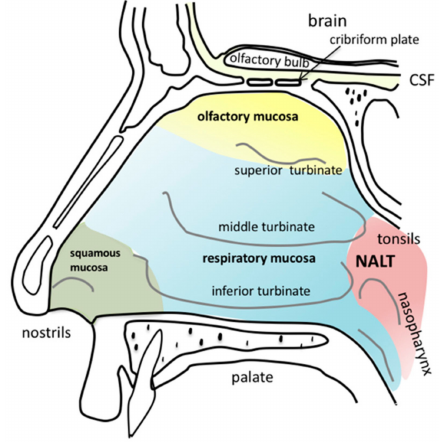
Figure 2. Anatomy of the human nasal cavity. Squamous mucosa (green) is located at the frontal parts of the nasal vestibules. The three turbinates (inferior, middle and superior) humidify and warm the inhaled air. The area covered predominantly with respiratory mucosa is labelled in blue. The olfactory mucosa (yellow) is located next to the cribriform plate at the skull base down to the superior turbinate. Nasally transmitted substances can cross the cribriform plate via different pathways to enter the brain. Nasopharynx-associated lymphatic tissue (NALT) is located in close proximity to the tonsils at the